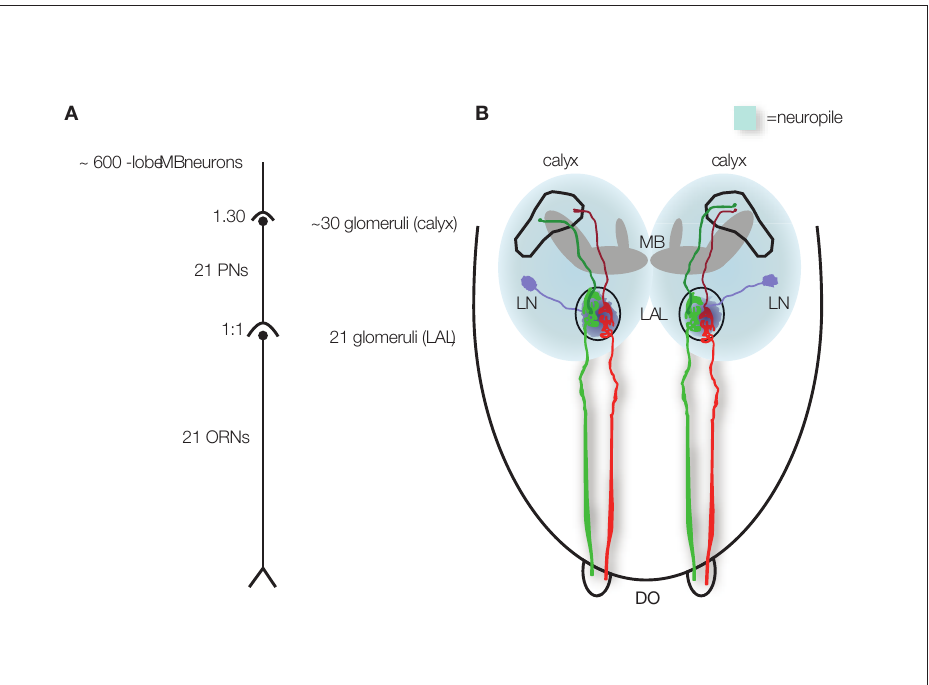
Figure 1 | Simplified wiring diagrams of the larval olfactory system. (A) Twenty-one ORNs are connected with 21 glomeruli in the LAL, and 21 PNs target ∼ 30 glomeruli in the mushroom body calyx and synapse onto ∼ 600 γ -lobe MB neurons. (B) Schematic illustration of the anatomical situation with individual ORNs (green or red) forming synapses with one PN each (dark green or dark red). PNs project to the calyx of the MB. LNs interconnect glomeruli in the LAL. The MB is shown in gray. DO, dorsal organ; LN, local interneurons; MB, mushroom bodies; PN, projection